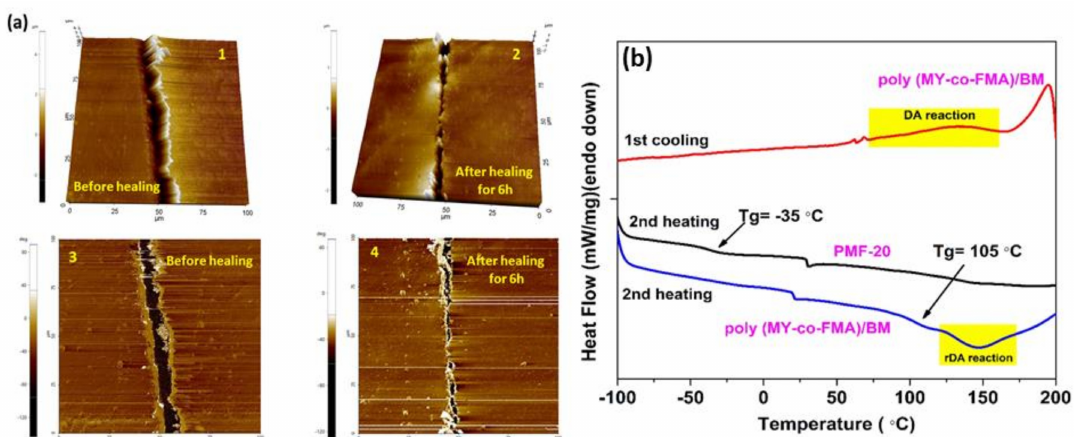
Figure 10. ( a ) Self-healing analysis by AFM imaging (1–4) of scratched and healed sample at 130 ◦ C for 6 h. ( b ) Thermoreversibility of Diels − Alder crosslinked polymer by DSC trace. Sample designations: ‘PMF-20’ represents a copolymer containing 20 wt. % furfuryl methacrylate, and ‘poly (MY- co -FMA) / BM’ indicates Diels − Alder adduct. (Reproduced from Reference 83, with permission from Wiley)